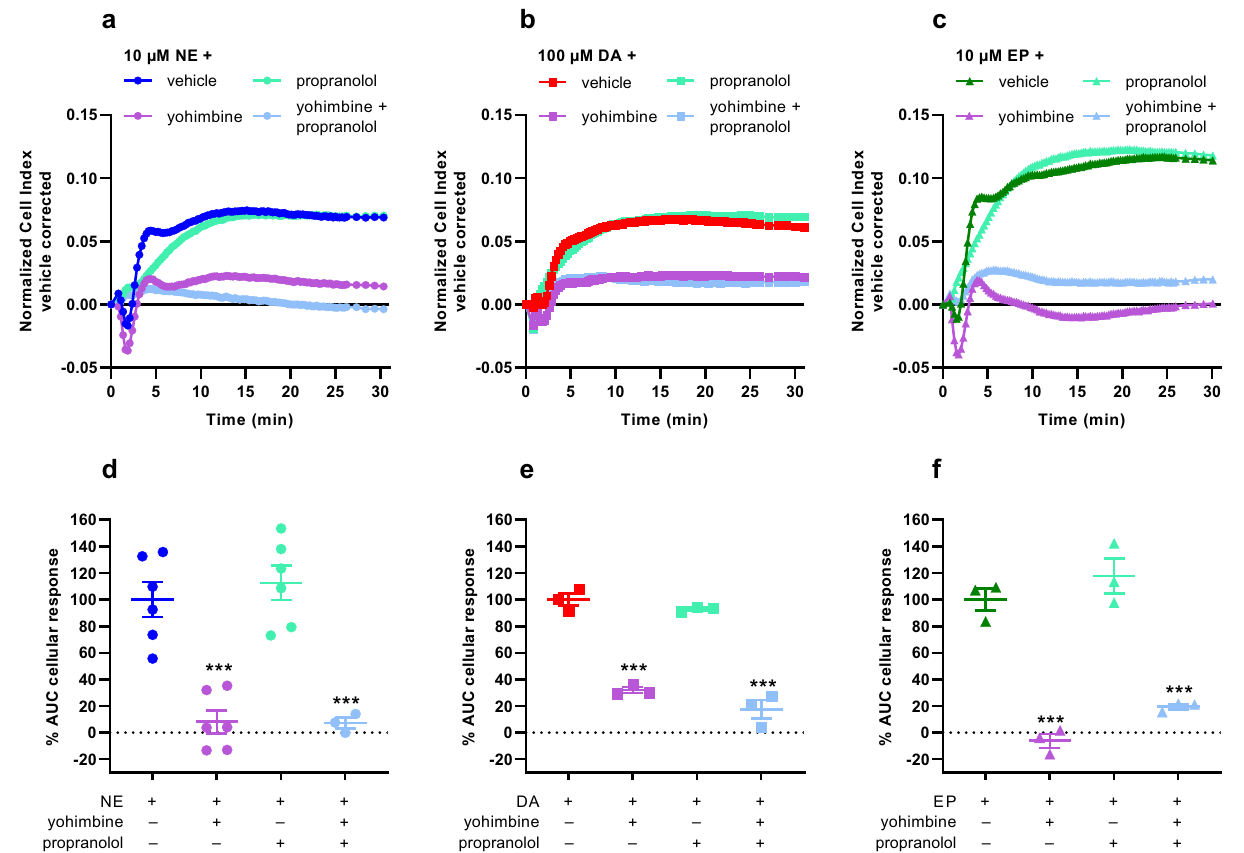
Figure 4. Assessment of GPCR involvement in substrate-specific cellular responses on dox-treated JumpIn- NET cells. Prior to stimulation with substrate, dox-treated cells were pretreated for 1 h with vehicle or 1 µM antagonist for α 2 ARs (yohimbine; purple) or βARs (propranolol; mint green) or a 1:1 mixture of both antagonists (light blue). Subsequently, cells were stimulated with an EC 80 of either ( a , d ) norepinephrine (NE, 10 µM; circle), ( b , e ) dopamine (DA, 100 µM; square), or ( c , f ) epinephrine (EP, 10 µM; triangle). ( a – c ) Representative vehicle-corrected normalized Cell Index traces of substrate-induced cellular responses. ( d – f ) Net AUC of the first 30 min after stimulation. Data are normalized to the response of the respective substrate (100%) in vehicle-pretreated cells. Data are shown as mean ± SEM of three to six individual experiments each performed in duplicate. Comparison of multiple mean values to vehicle control was done using a one-way ANOVA with Dunnett’s post-hoc test. *** p < 0.001 compared to substrate